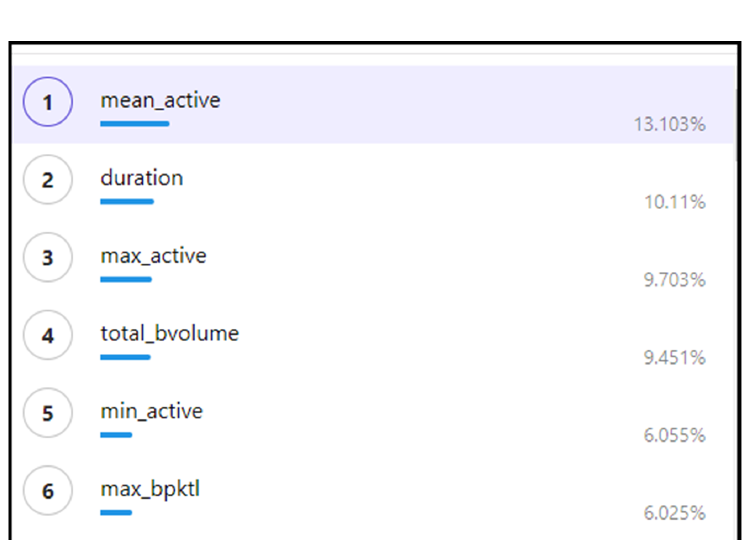
Figure 7. Feature impact scores.